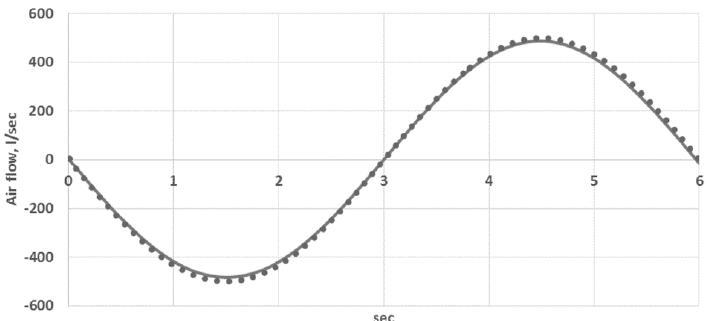
Figure 2. Comparison of the calculated and measured alveolar air flow (L/sec): curve—the data from [29], dots—simulations. Computation 2017 , 5 , 11 11 of 19